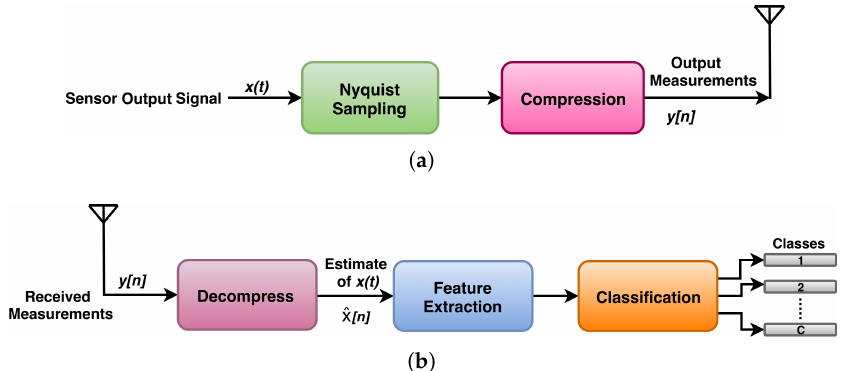
Figure 1. Scenario representing WSN implementation using Nyquist sampling technique: ( a ) sensor node and ( b ) base station.